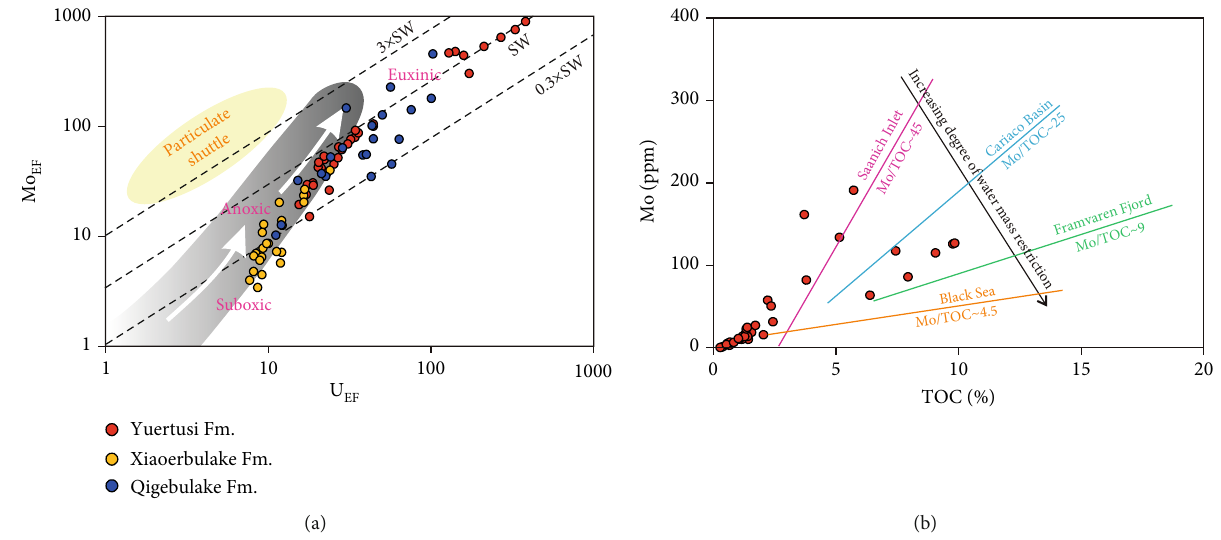
Figure 9: (a) Mo -U covariation pattern indicating redox conditions for well Luntan 1. (b) Mo/TOC ratio indicating water mass EF EF restriction during the Yuertusi period. The base graphs were cited from [60, 61],